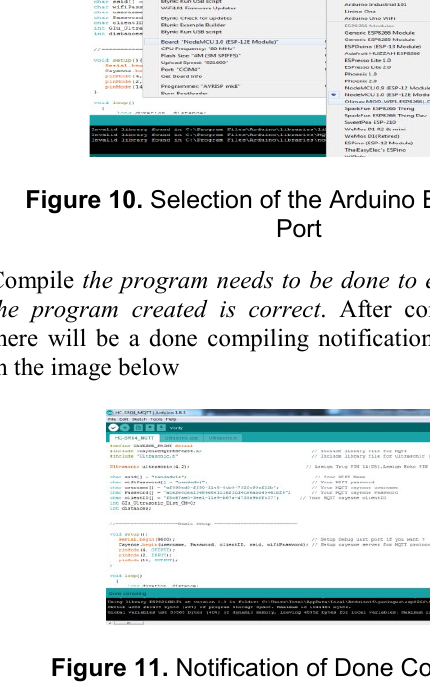
Figure 11. Notification of Done Compiling